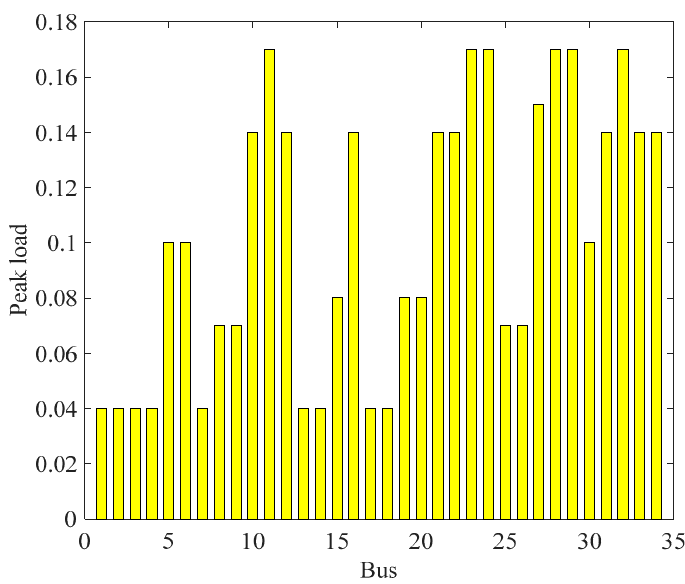
Figure 3. The amount of peak load per bus.